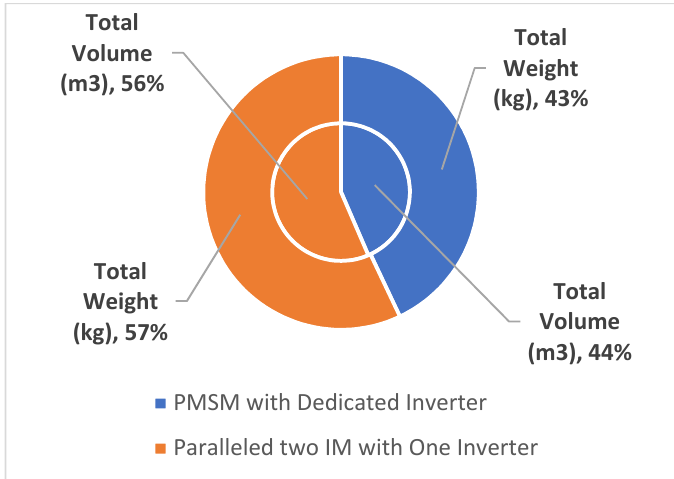
Figure 9. Overall volume and weight comparison.